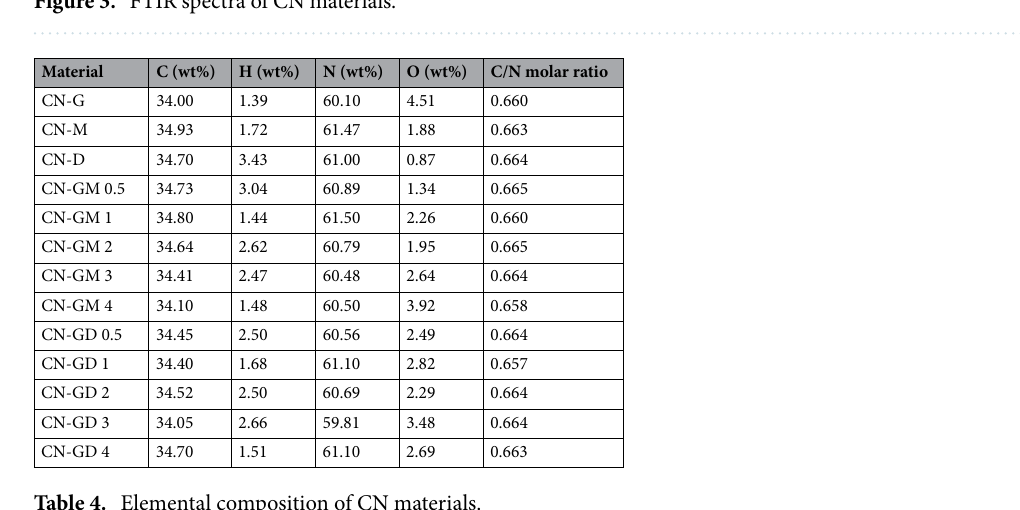
Table 4. Elemental composition of CN